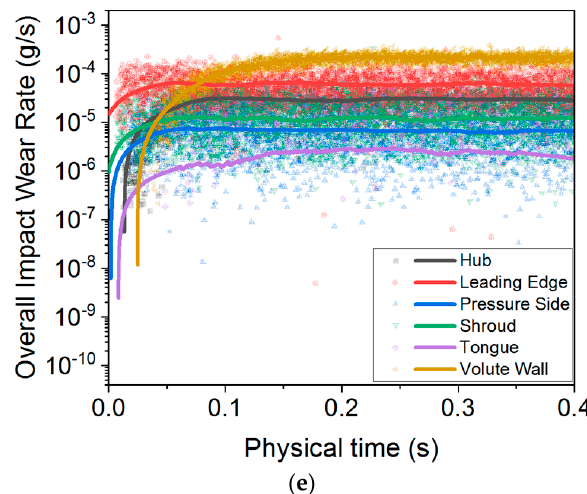
Figure 6. Overall impact wear rate of flow parts as a function of time: ( a ) tetrahedron, ( b ) hexahedron, ( c ) octahedron, ( d ) dodecahedron, and ( e ) sphere.